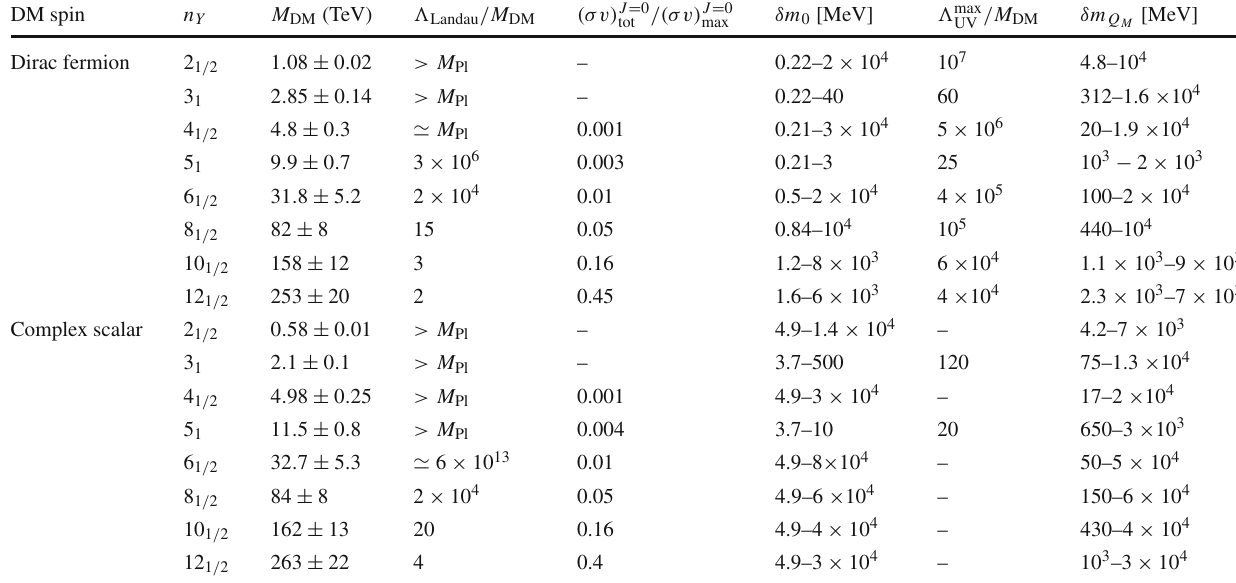
Table 1 Thermal masses of complex WIMPs with Y (cid:2)= 0, obtained the minimal viable splitting is smaller than 10 M DM . For each candidate we provide the allowed range for the mass splittings. The lower limit including Sommerfeld enhancement and BSF. The upper bound on n on δ m 0 comes from strongest bound between direct detection and BBN for even multiplets comes from the perturbative unitarity bound, as can be seen from the (σv) J = 0 tot /(σv) J = 0 max , where (σv) J = 0 max is the max- as shown in Fig. 1. The upper bound from the most stringent condition between DD constraint from PandaX-4T [5] and the perturbativity of imal allowed annihilation cross section [4]. The loss of perturbativity the coupling of O 0 in Eq. (1). Similarly, the lower limit on δ m Q is also signaled by the Landau pole (cid:4) Landau progressively approaching the DM mass. The upper bound on odd n with Y = 1 comes from the from the BBN bound on the charged state decay rate, while the upper perturbativity of the higher dimensional operators generating δ m 0 . For limit from the strongest limit between DD and the perturbativity of the coupling of O + in Eq. multiplets with n > 5 the largest UV cutoff (cid:4) max required to generate UV